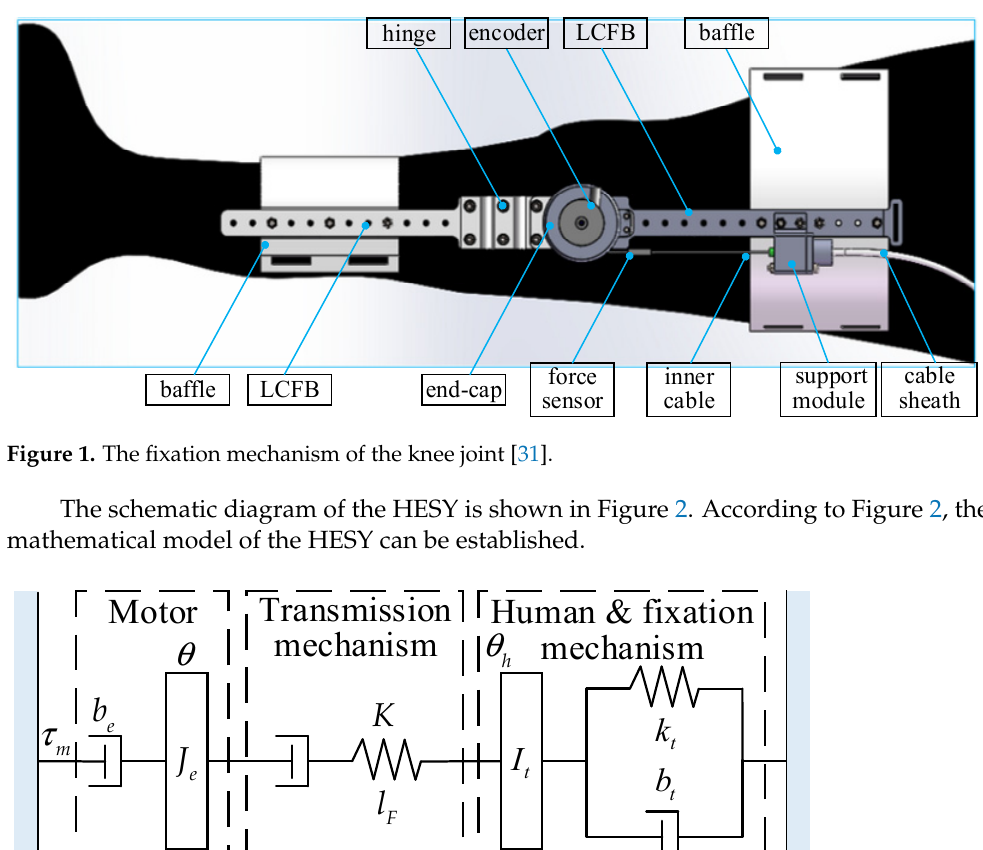
J b and e are the J b θ and e are the θ l are l are